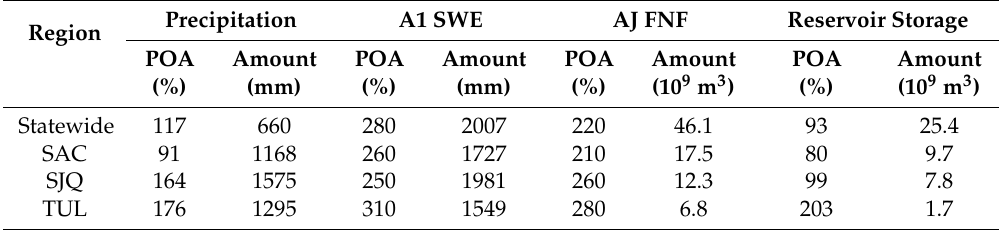
Figure 2. Percent of Average of (POA) of annual precipitation, A1 SWE, AJ FNF, and reservoir storage (September) from water year 2011–2015 for regions: ( a ) Statewide; ( b ) Sacramento (SAC); ( c ) San Joaquin (SJQ); ( d ) Tulare (TUL). X -axis indicates water years. The average value (applied in POA calculation) is determined in the entire record period as tabulated in Table 2. Table 4. Four-year (2012–2015) accumulated deficiencies of study variables 1